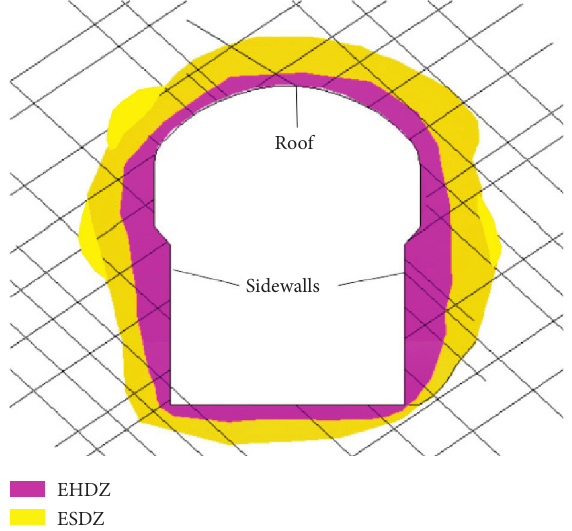
Figure 8: The excavation damage zones proposed by Xu et al. [34, 37]. Note that UDZ is not illustrated in the figure. Figure 9: Principle of acoustic velocity testing system, modified after Tao et al.